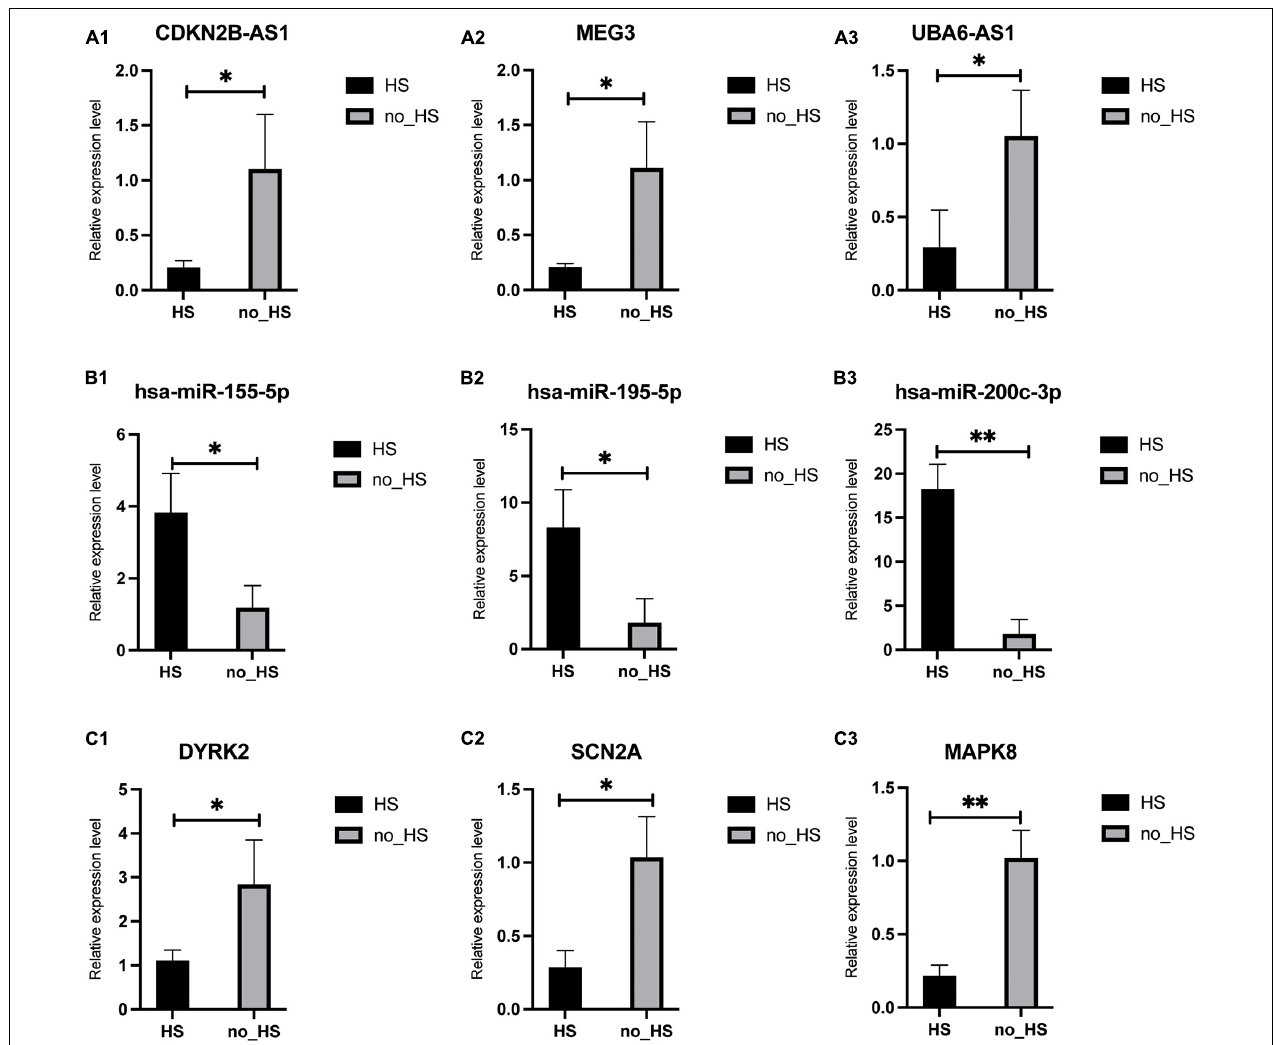
FIGURE 9 | Validation of RNAs in core neuronal apoptosis ceRNA in HS and no-HS patients. All 9 RNA transcripts were verified in a cohort of HS ( n = 6), no-HS ( n = 6) hippocampus samples. lncRNA: (A1–A3) ; miRNA: (B1–B3) ; mRNA: (C1–C3) . ∗ p < 0.05, ∗∗ p <